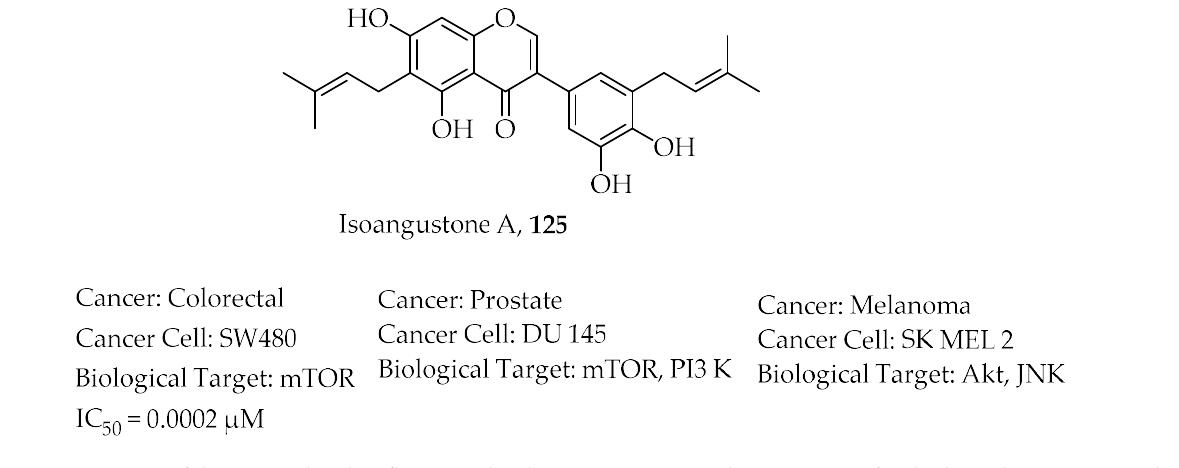
Figure 21. Structure of the 6-prenylated isoflavanone lipid Isoangustone A with a summary of its biological activity towards selected cancer targets.